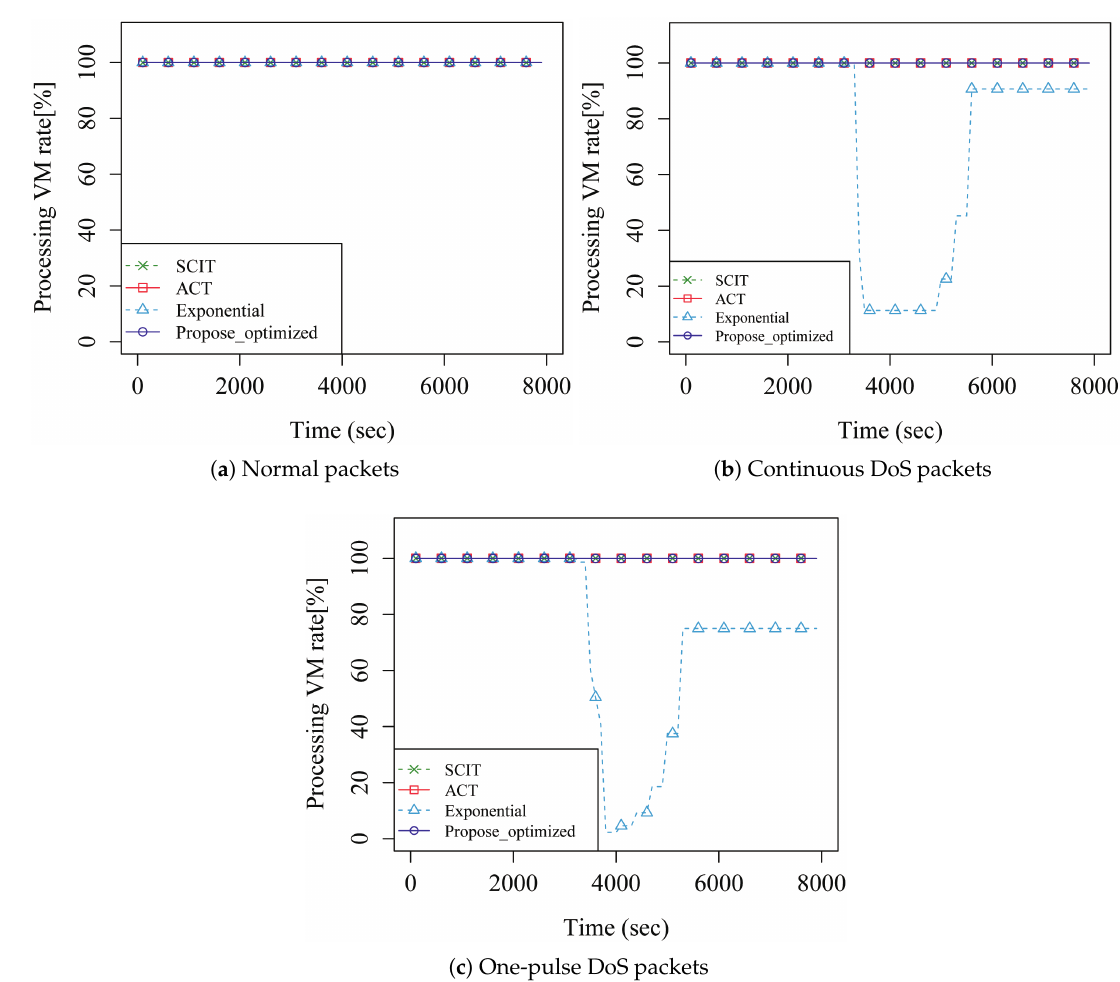
Figure 6. VM processing rate in three scenarios. ( a ) normal packets; ( b ) continuous DoS